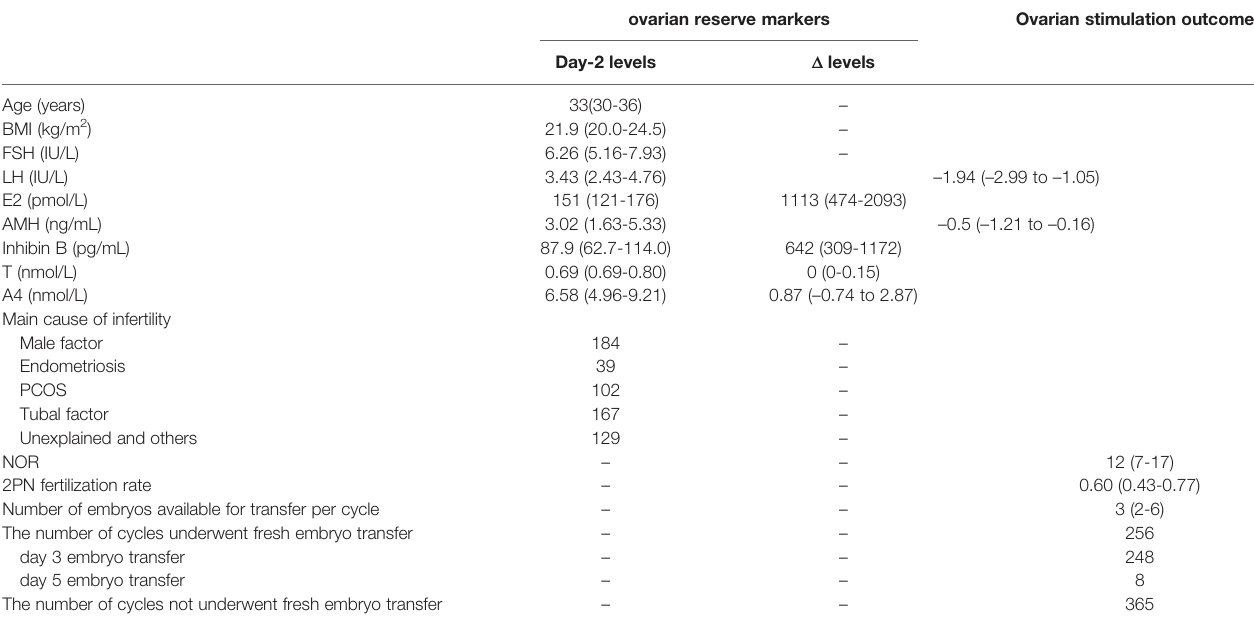
TABLE 1 | Ovarian reserve markers of basal (day-2) and dynamic (day-6 minus day-2) levels in classical GnRH-antagonist